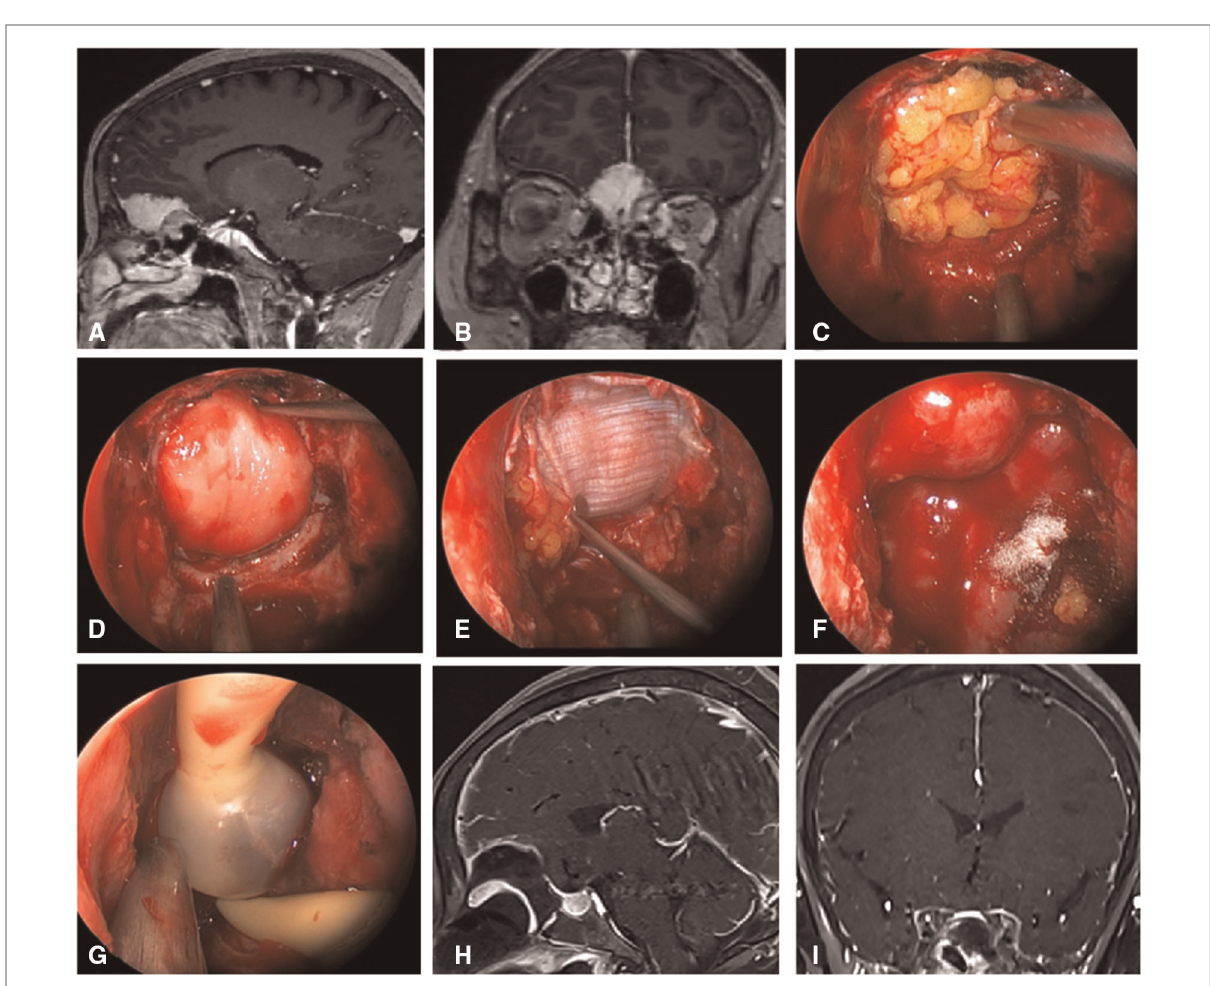
FIGURE 2 Changes in reconstruction strategy/(before). ( A,B ) Sagittal and coronal enhanced MRI in sellar region before operation, and olfactory groove meningioma was considered. ( C ) Subdural fat packing. ( D ) Arti fi cial dura mater embedded between cellulite and dura mater. ( E ) Cover the fascia lata on the arti fi cial dura mater. ( F ) Cover the VP-NSF on the fascia lata. ( G ) Balloon support. ( H,I ) Sagittal and coronal enhanced MRI in sellar region after operation, and postoperative pathology showed